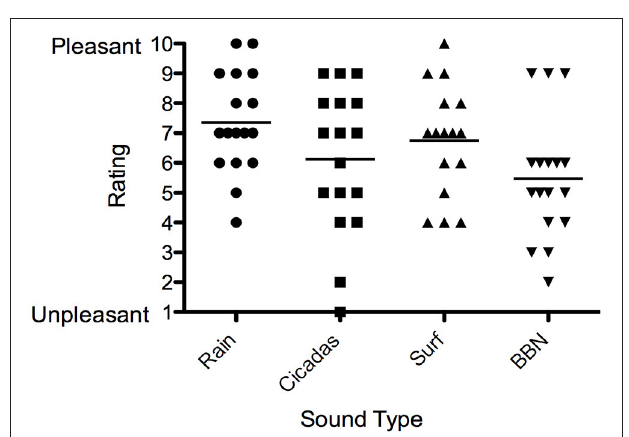
FIGURE 5 | Valence ratings of sound therapy stimuli [Rain (circles), Cicadas on Farm (squares), Surf (triangles), BBN (inverted triangles)] by participants. Horizontal lines represent average valence ratings for each sound stimulus.